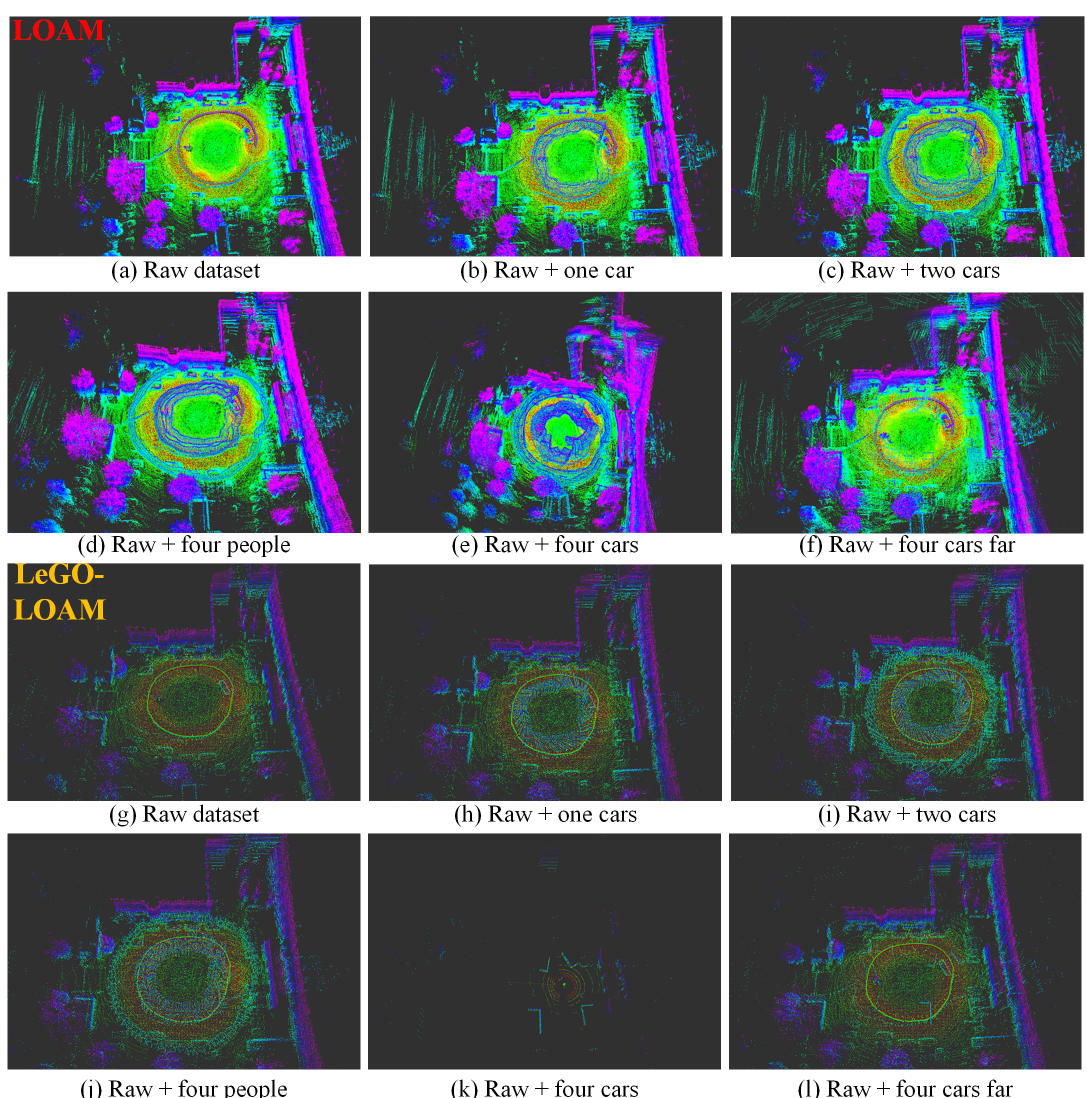
Figure 15. The mapping results (3D view) of LOAM ( a – f ) and LeGO-LOAM ( g – l ) in different simulated scenarios based on flowerbed_sim. ( a , g ) are the results on the original static data, used as baseline. More dynamic objects result in more obvious mapping error such as ( e ), or even total failure in some scenarios such as ( k